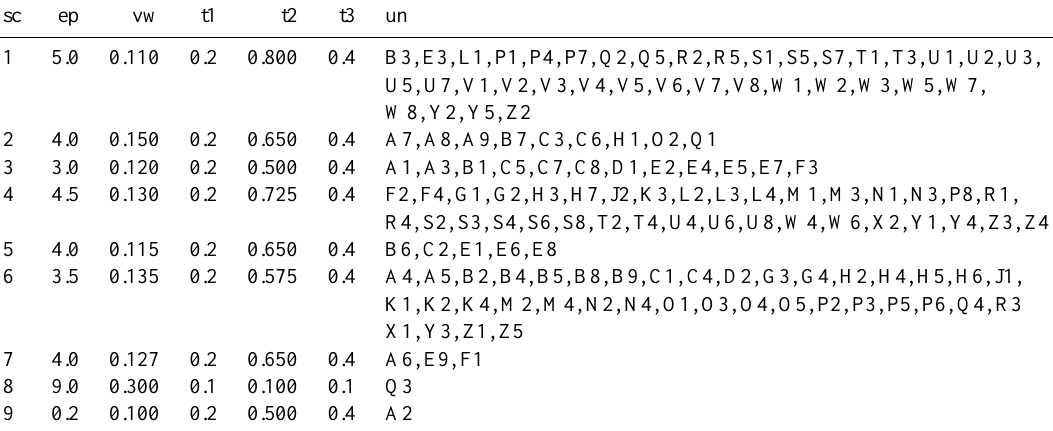
Table D7. Soil classification. sc: LPJ-GUESS soil code; ep: empirical parameter in percolation equation (mmday − 1 ); vw: volumetric water holding capacity (WHC) at field capacity minus WHC at wilting point, as fraction of soil layer depth; t1–t3: thermal diffusivities (TD;